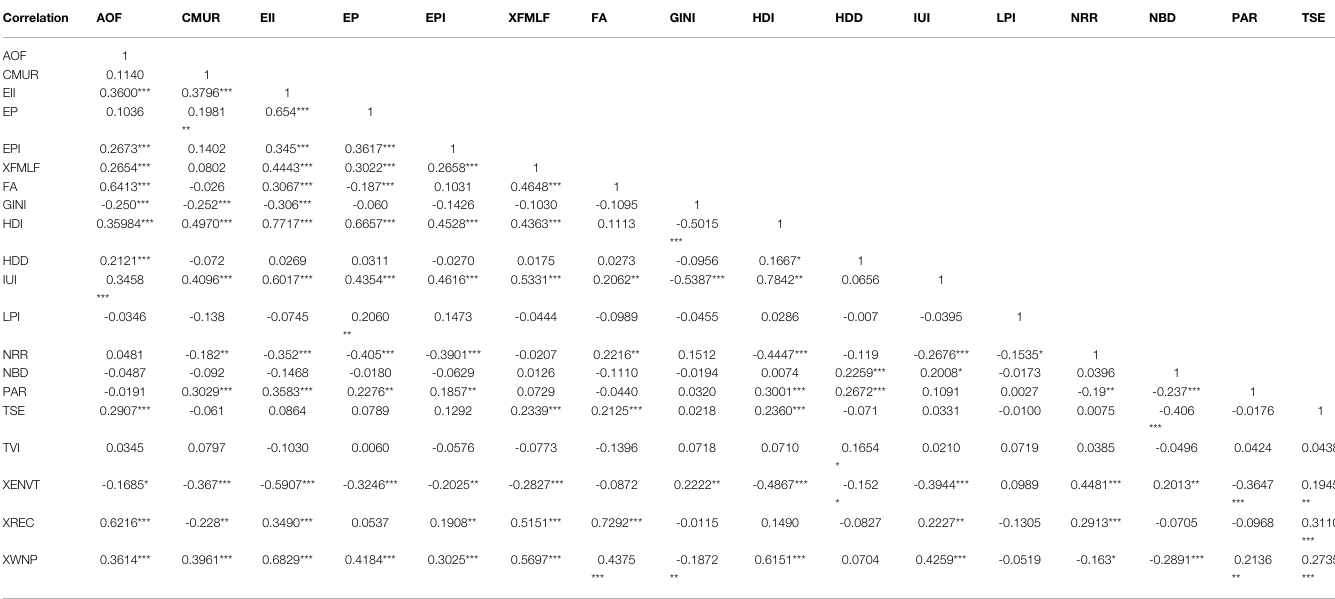
TABLE 3 | Correlation matrix between variables included into the analysis.